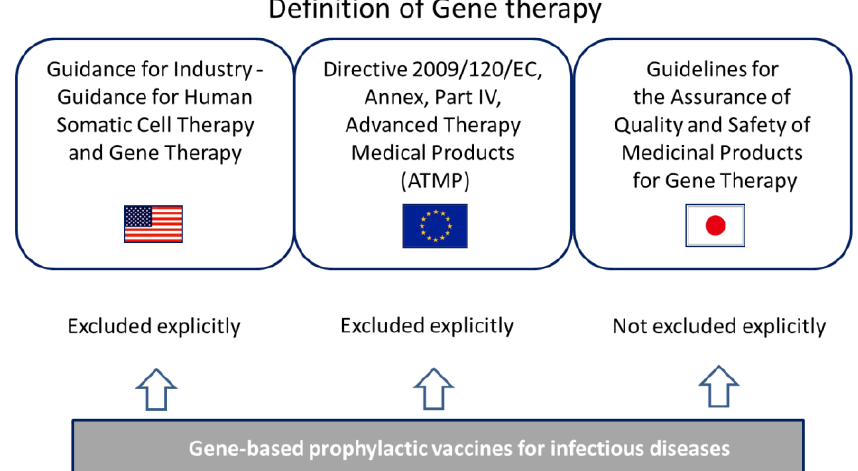
Figure 4. Relationship between gene therapy and gene-based